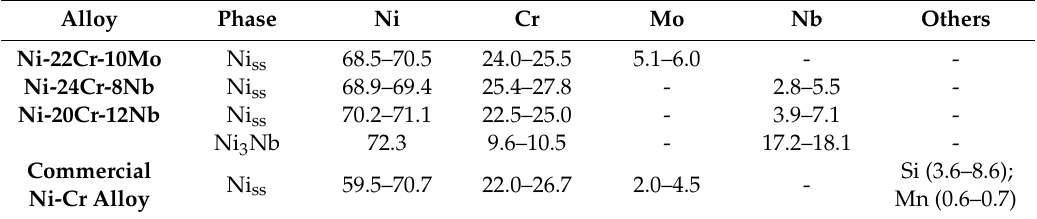
Table 3. The elemental contents (at. %) measured by electron dispersive spectrometry (EDS) analysis of phases formed in the as-cast Ni-Cr-Nb and Ni-Cr-Mo alloys.